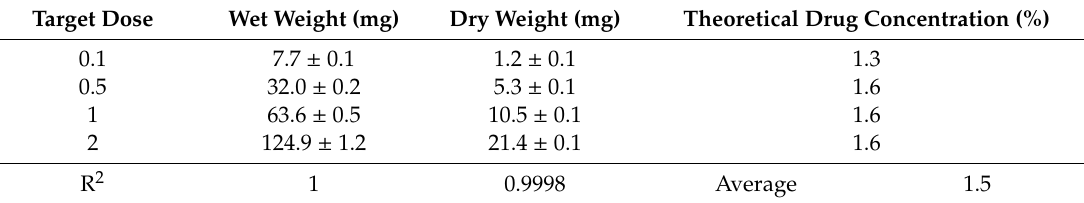
Table 3. Wet and dry weights of the placebo EXT ODFs used to determine the drug load in the printing